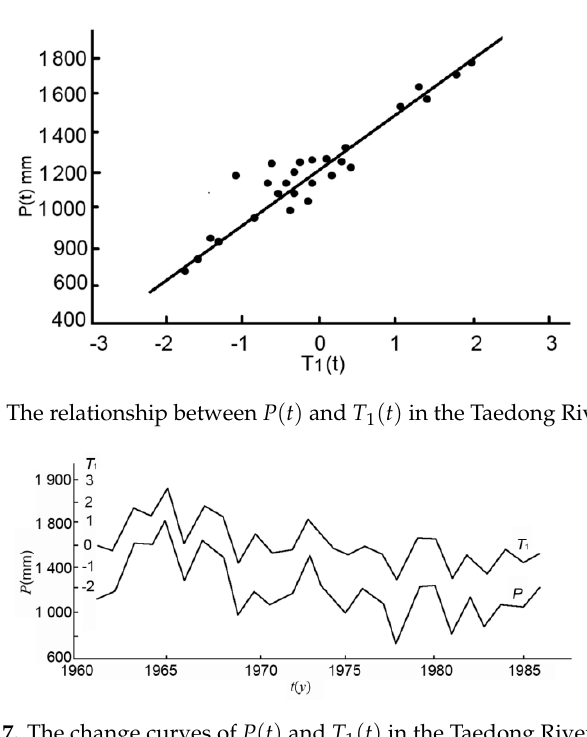
( ) T t in the Taedong River Basin. 1